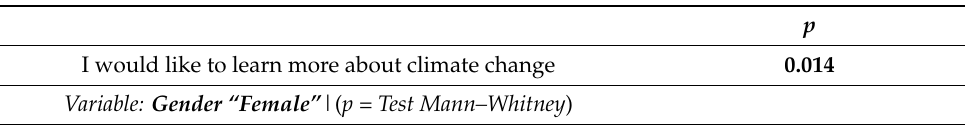
Table 6. Significant results of the comparison of the degree of agreement with the climate change statements according to gender ( p = Test Mann – Whitney).